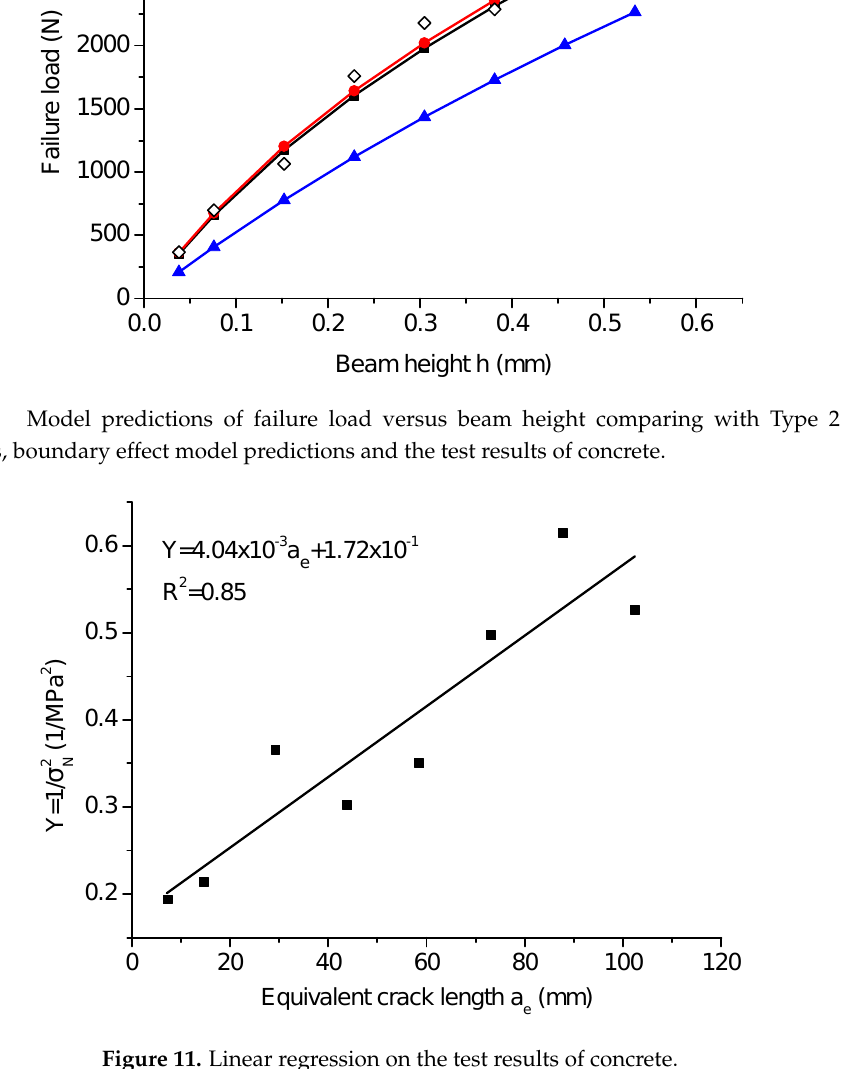
Figure 11. Linear regression on the test results of